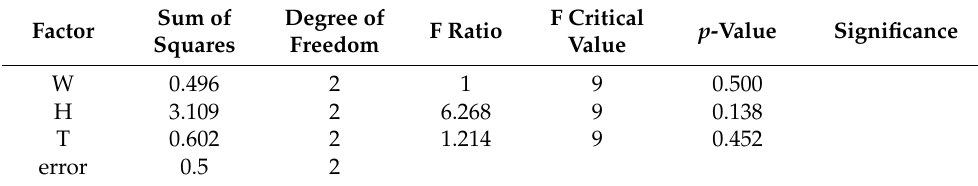
error 0.5 2 Significant level α =